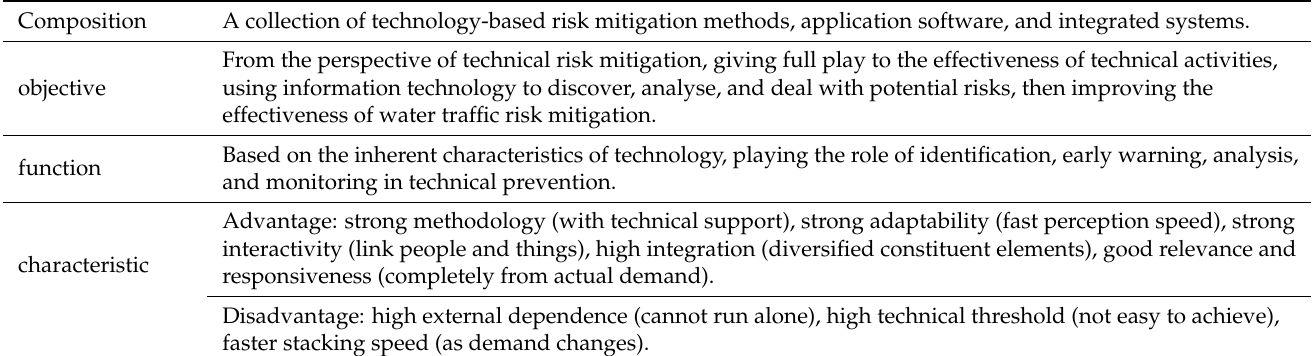
Table 3. Details of the technical defence subsystem of the